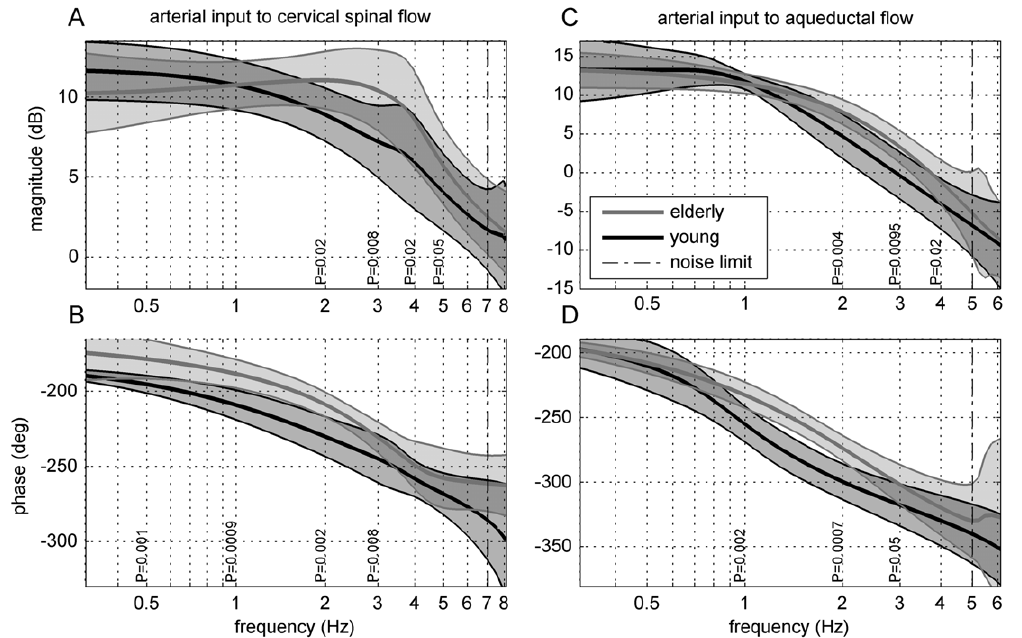
Figure 3. Mean magnitude and phase of transfer function (bold line) and standard deviation (gray shading) from arterial input to cervical spinal cerebrospinal fluid (CSF) flow, A and B, at the level of C3–C4, and to aqueductal CSF flow, C and D, of elderly (gray line) and young (black line) groups as a function of frequencies. Significant differences of the magnitude and phase as detected by the Mann-Whitney test are depicted at the respective frequency. At 2 Hz the phases of the arterial-to-aqueductal flows hardly overlap D , resulting in an asymptotic 2-tailed p-value of 0 : 0007 .